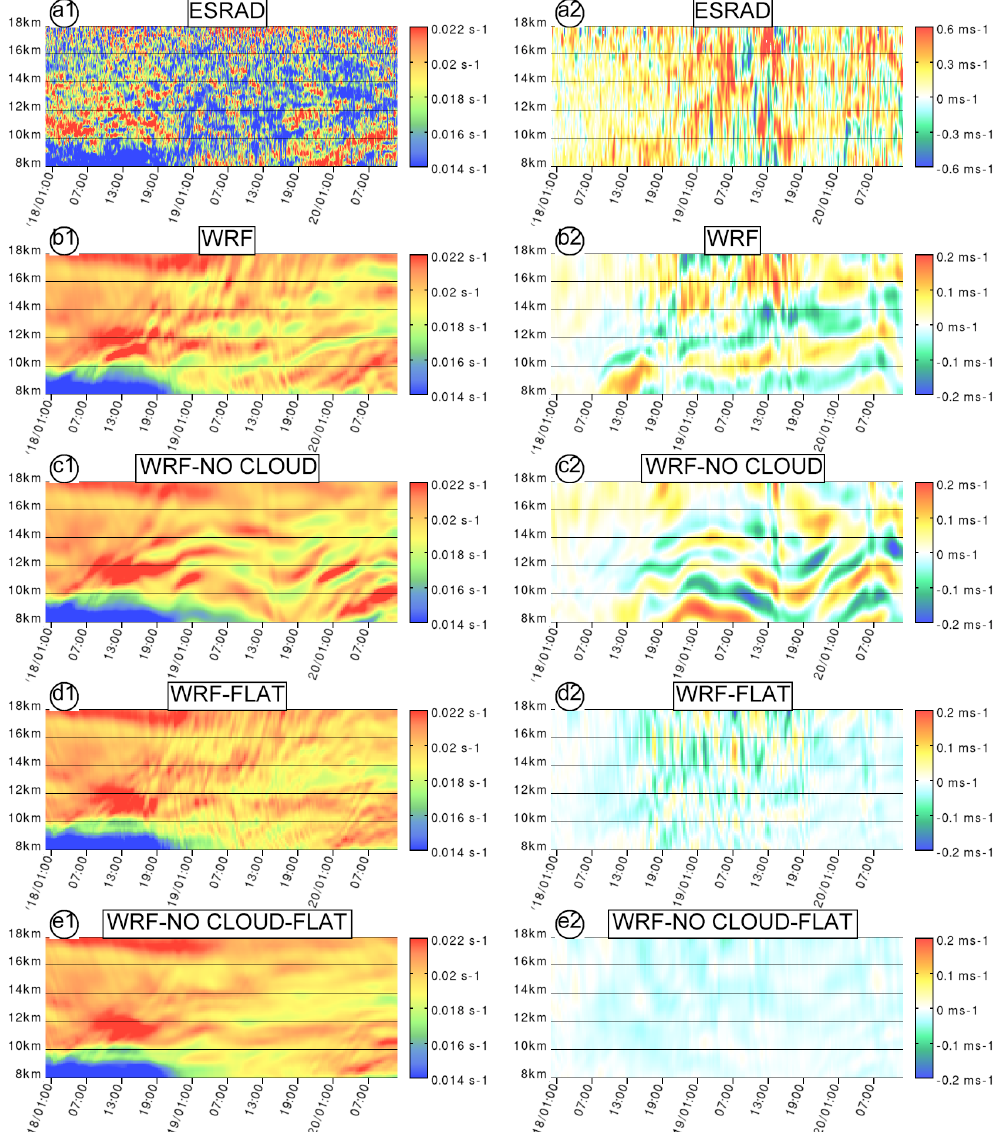
Figure 3. (a) Time-height diagram of 1) buoyancy frequency (colours) in s -1 ,and 2) 688 Fig. 3. (a) Time–height diagram of (1) buoyancy frequency (colours) in s − 1 ,and (2) vertical velocity from ESRAD observations. The hori- zontal axis gives the time in days from 00:00UTC on 18 February 2007 to 12:00UTC on 20 February 2007, and the vertical axis gives the vertical velocity from ESRAD observations. The horizontal axis gives the time in days 689 height in km. The buoyancy frequency and vertical velocity scales are given by the coloured bar on the right of each panel. (b) , As in (a) , except from the WRF model experiment with clouds and orography. (c) , As in (a) , except from the WRF model experiment without clouds from 0000 UTC on 18 February 2007 to 1200 UTC on 20 February 2007, and the vertical 690 but with orography. (d) , As in (a) , except from the WRF model experiment with clouds but without orography. (e) , As in (a) , except from the WRF model experiment without clouds and without orography. axis gives the height in km. The buoyancy frequency and vertical velocity scales are 691 given by the coloured bar on the right of each panel. (b) As in (a), except from the WRF 692 horizontal bands of upward or downward vertical winds later, model experiment with clouds and orography. (c), As in (a), except from the WRF model 693 thus supporting the use of using buoyancy frequency to diag- nose the gravity wave activity in the lower experiment without clouds but with orography. (d), As in (a), except from the WRF 694